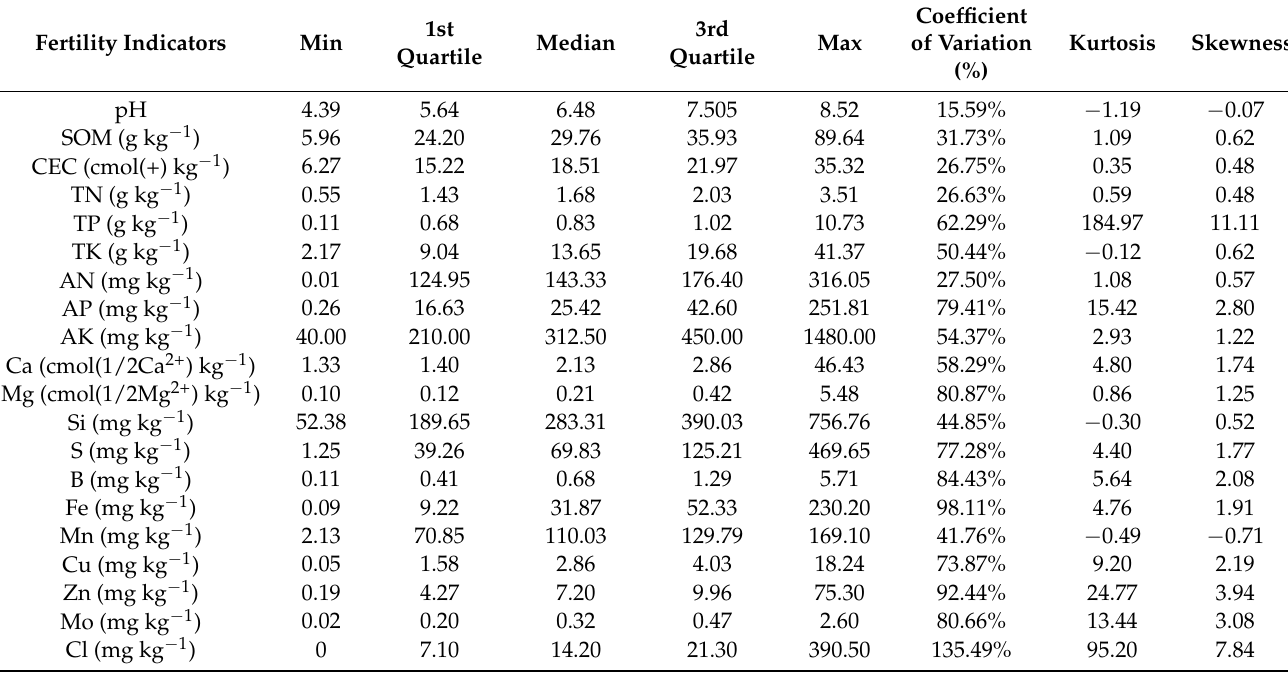
Table 2. Statistical summary of the 20 soil fertility